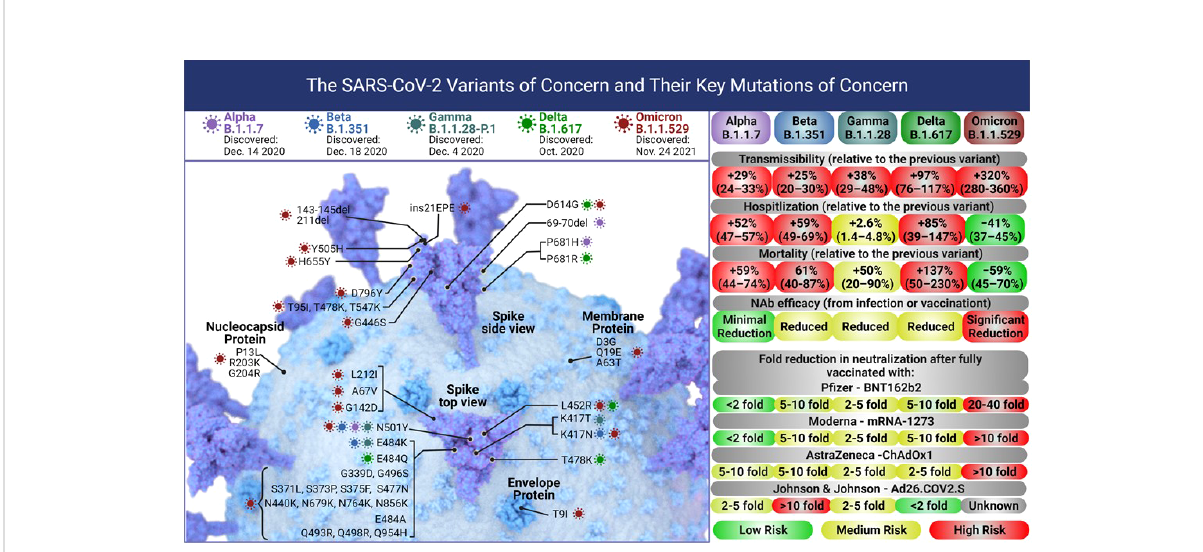
FIGURE 3 Each of the fi ve SARS – CoV-2 variants of concern accumulated mutations in their Spike protein leading to changes in their transmissibility, and severity of infections leading to hospitalization or death. The current globally dominant variant, Omicron (B.1.1.529) has more than 50 mutations including 32 on the Spike protein and 15 on the RBD alone. These mutations have signi fi cantly increased the transmissibility of Omicron over the Delta variant. The severity (hospitalization and death) due to the Omicron variant is lower than Delta, however, the vaccine ef fi cacy against Omicron drops signi fi cantly. Figure created with